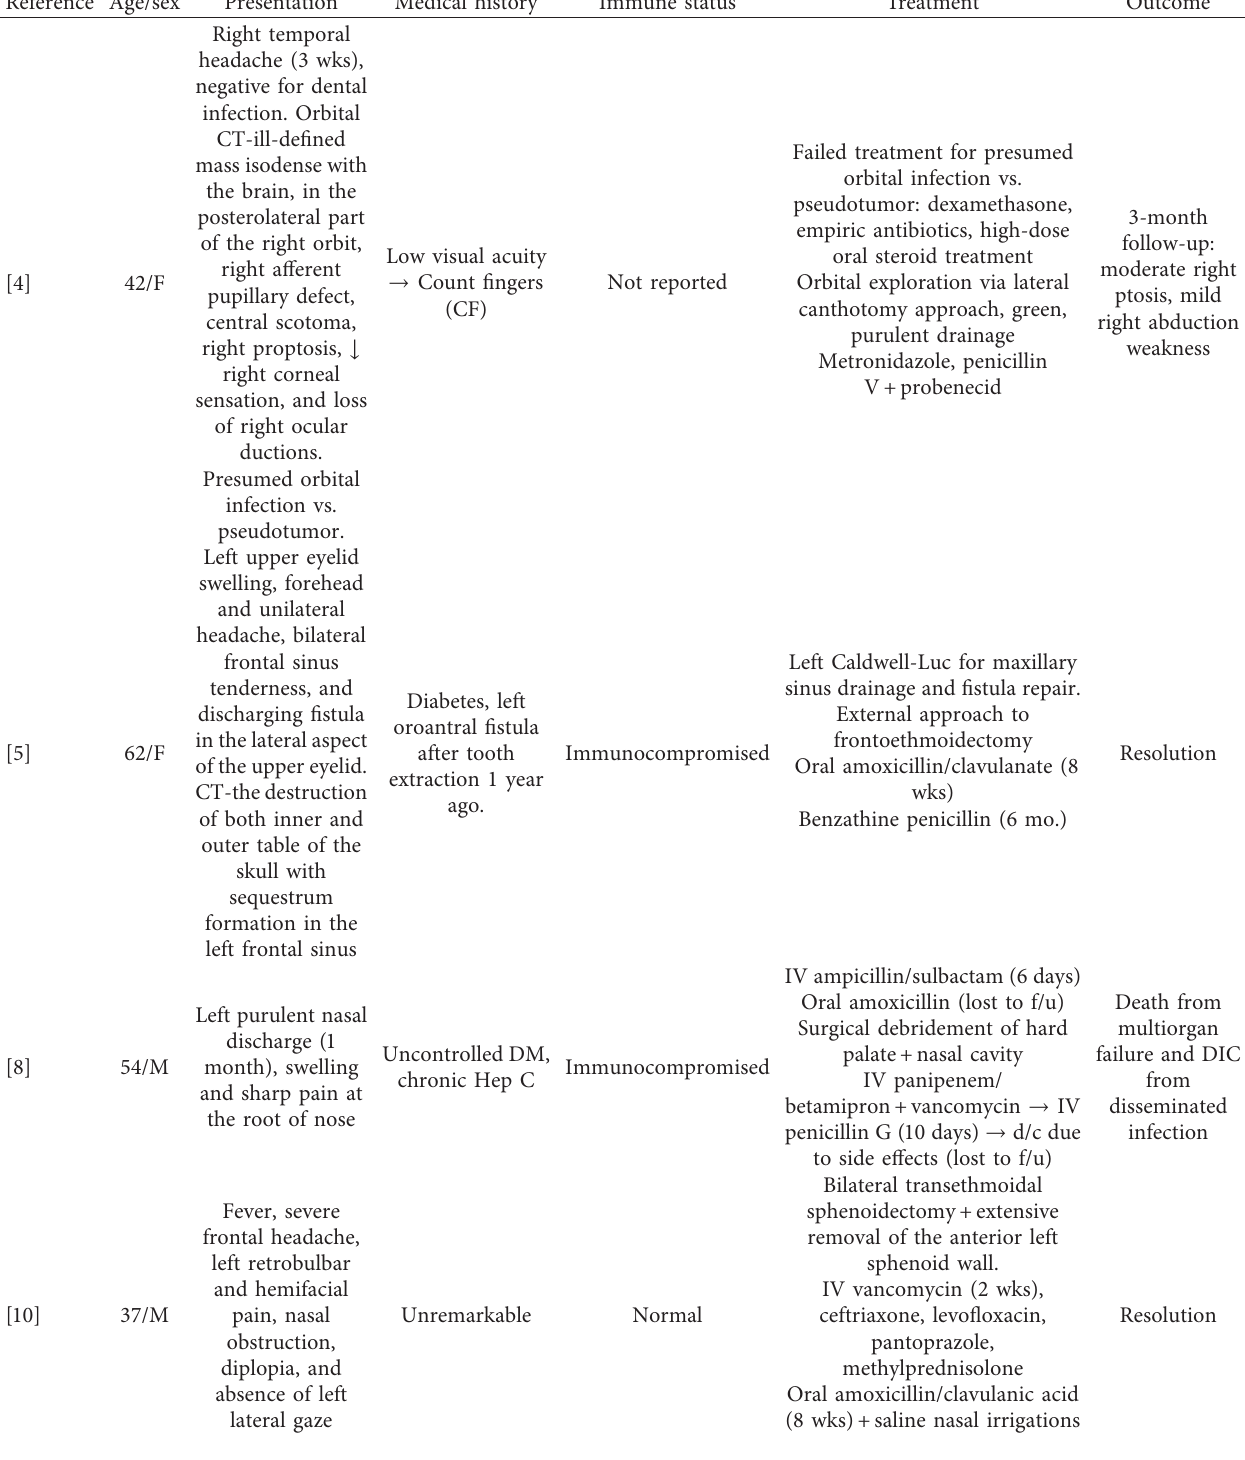
Table 1: Cases of paranasal sinus actinomycosis with